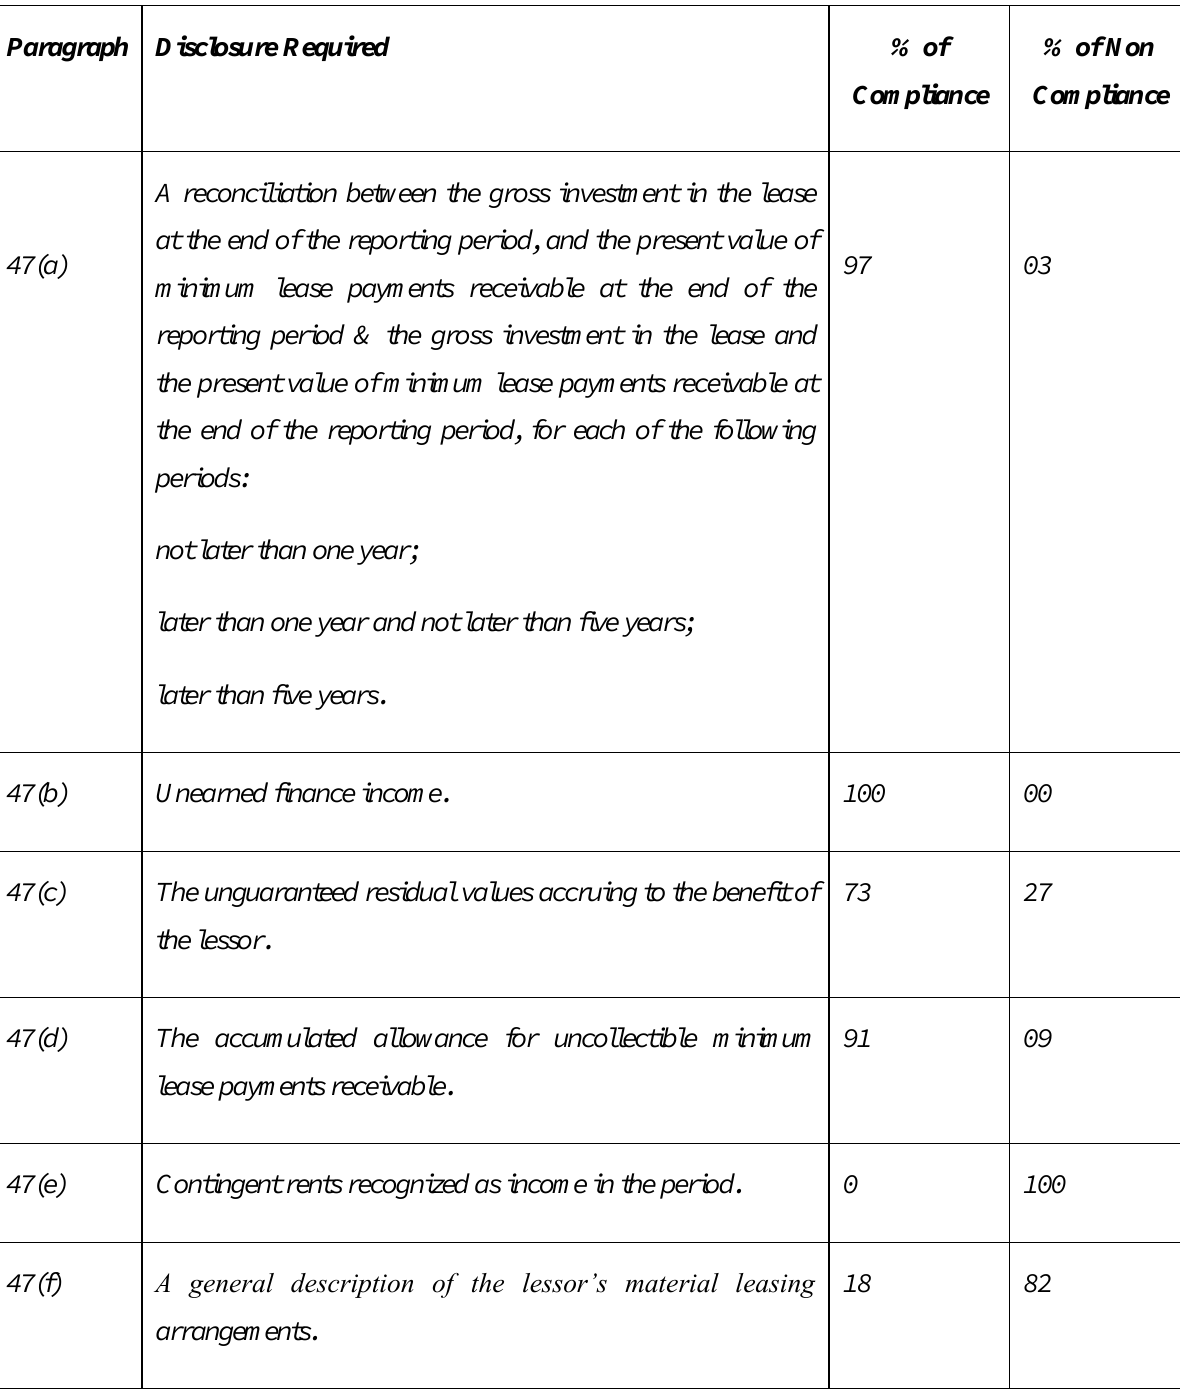
Table 03: Checklist as per paragraph 47 of LKAS 17